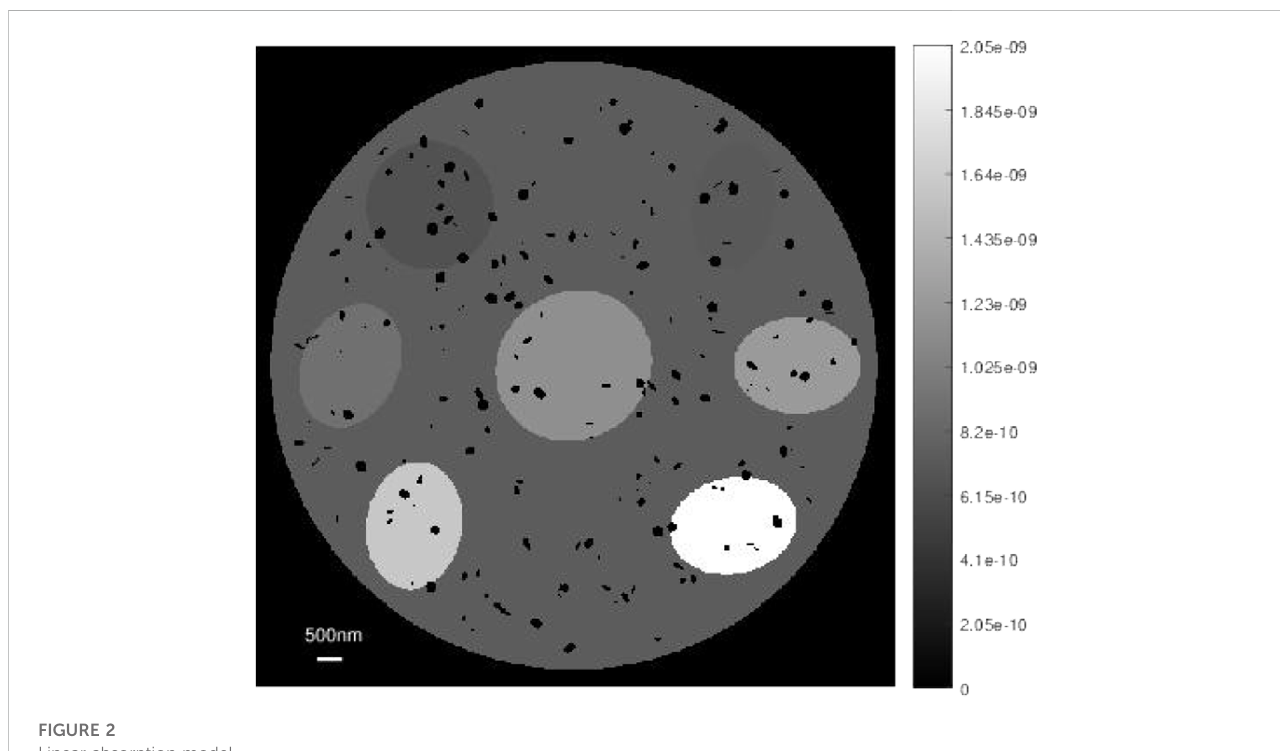
FIGURE 2 Linear absorption model.